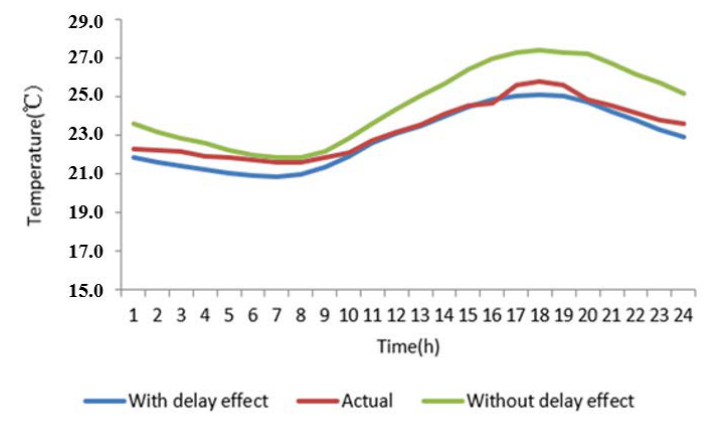
Figure 7. The temperature in three modes.